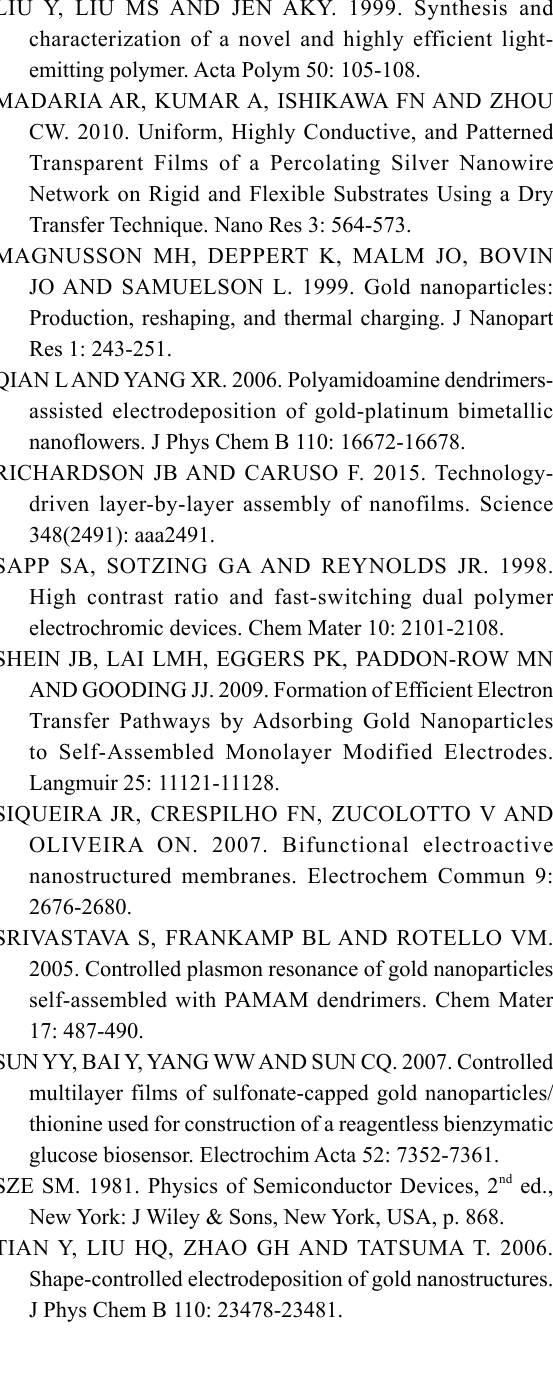
Figure S2 - Distance distribution histogram of the counting number of 100 dendritic AuNPs distances vs. distance between each dendritic AuNPs structures evaluated by the AFm image of figure 5a. Selected area: 600 x 20 µm (Image J software, image processing and